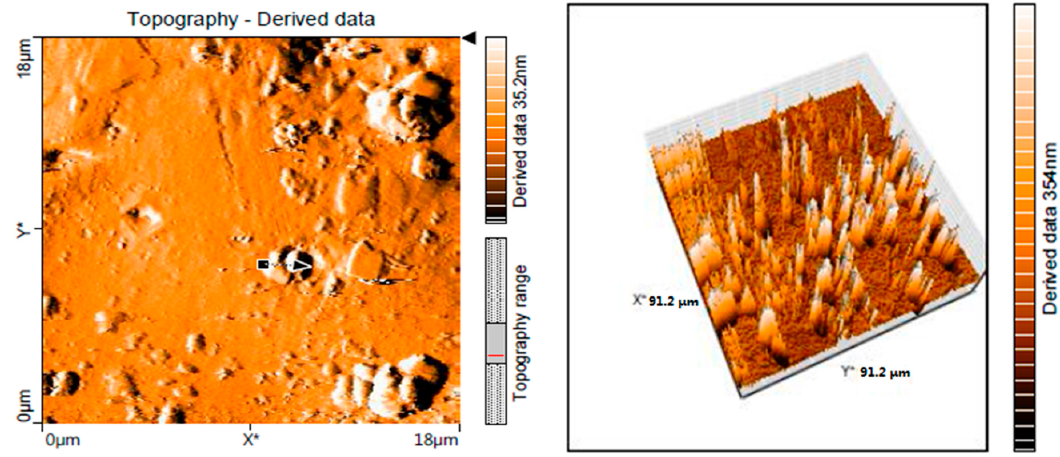
Figure 11. 2D and 3D AFM images of PVC film containing Ni(II) exposed to UV light for 250 h.